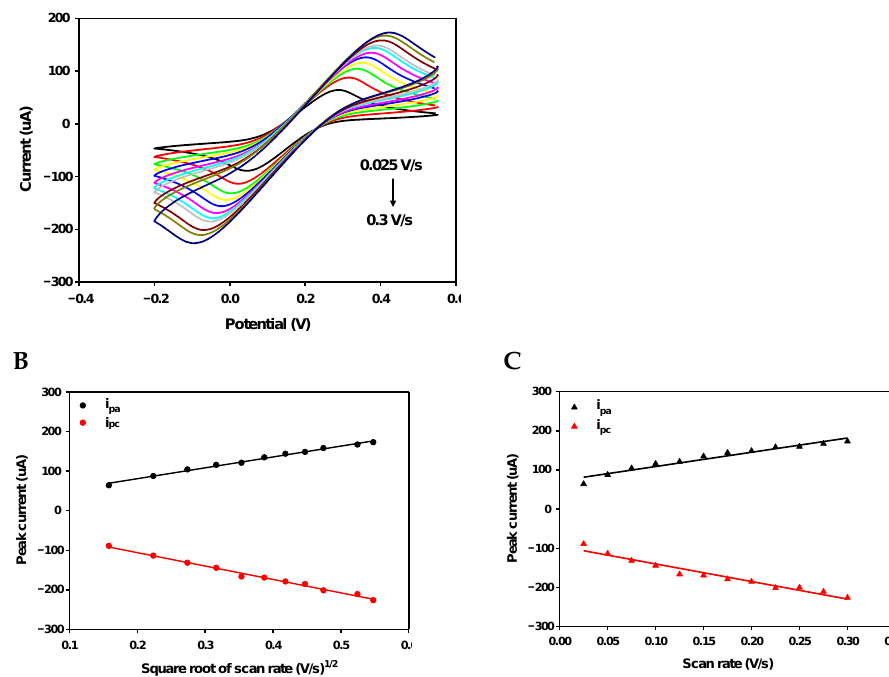
Figure A7. CV voltammograms of the aminated electrode under various scan rates from 0.025 V/s to 0.3 V/s (0.025, 0.05, 0.075, 0.1, 0.125, 0.15, 0.175, 0.2, 0.225, 0.275 and 0.3 V/s) ( A ). Anodic